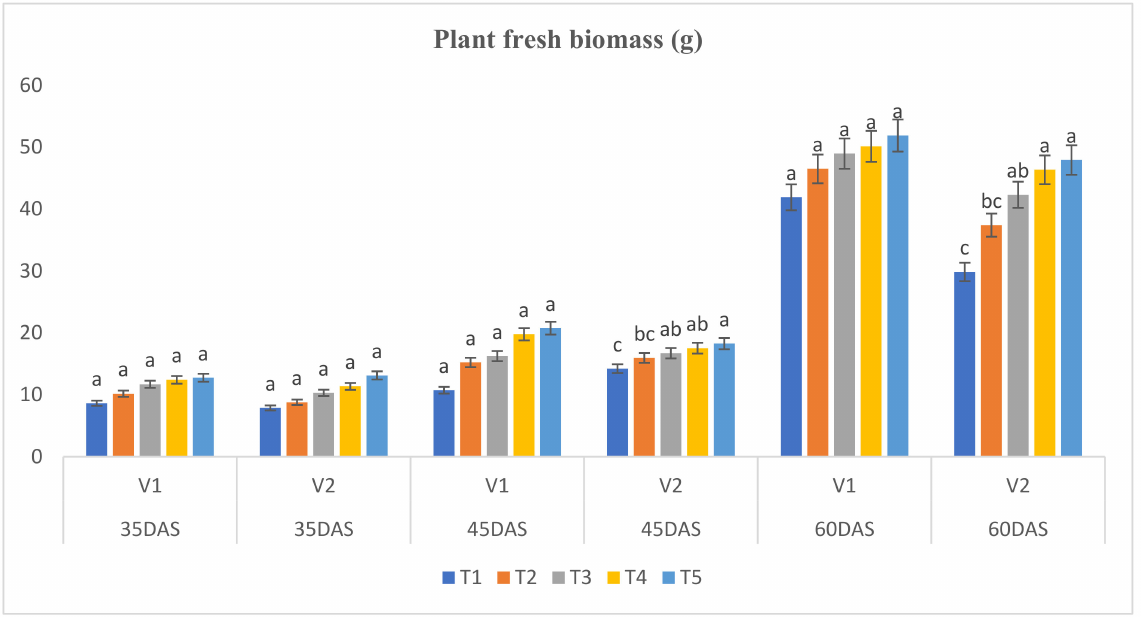
Figure 4. Effect of hydro, Mg(NO 3 ) 2 , ZnSO 4 , Mg(NO 3 ) 2 + ZnSO 4 primed, and nonprimed (control) seed treatments on total plant fresh biomass (g) of wheat varieties, grown in the year 2017–2018. The full description of abbreviations T1, T2, T3, T4, T5, V1 and V2 are represented in material and methods section. Lowercase alphabetical letters (a,b,c) represents the significant differences between the different seed priming treatments (Tukey test; p <